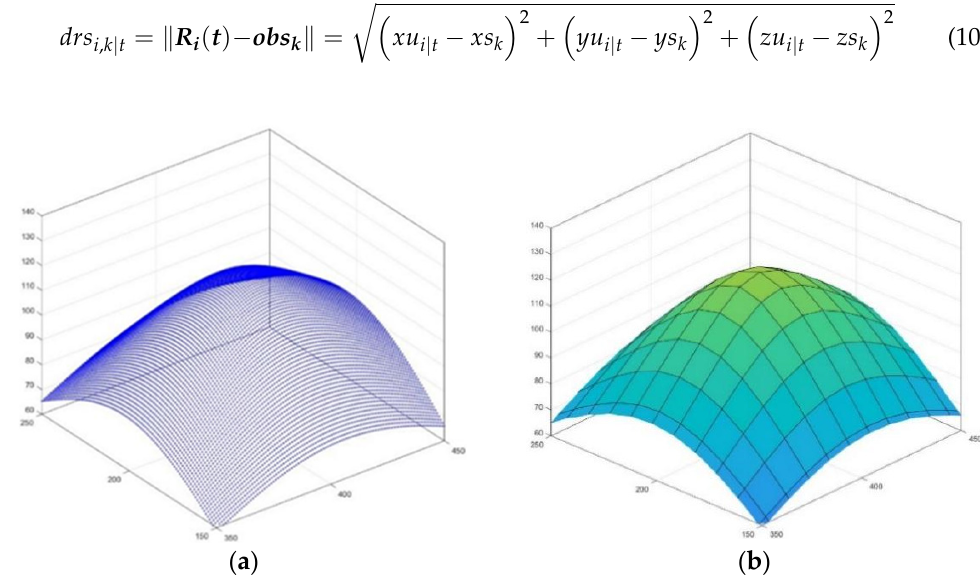
Figure 3. Discretization of a mountain. ( a ) Mountain, ( b ) mountain